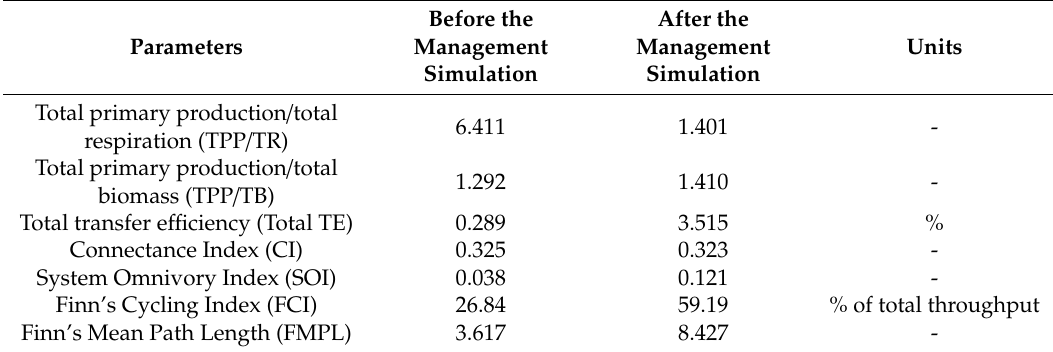
Table 6. Key indicators of the Lake Datong ecosystem before and after the management simulation. Before the Parameters